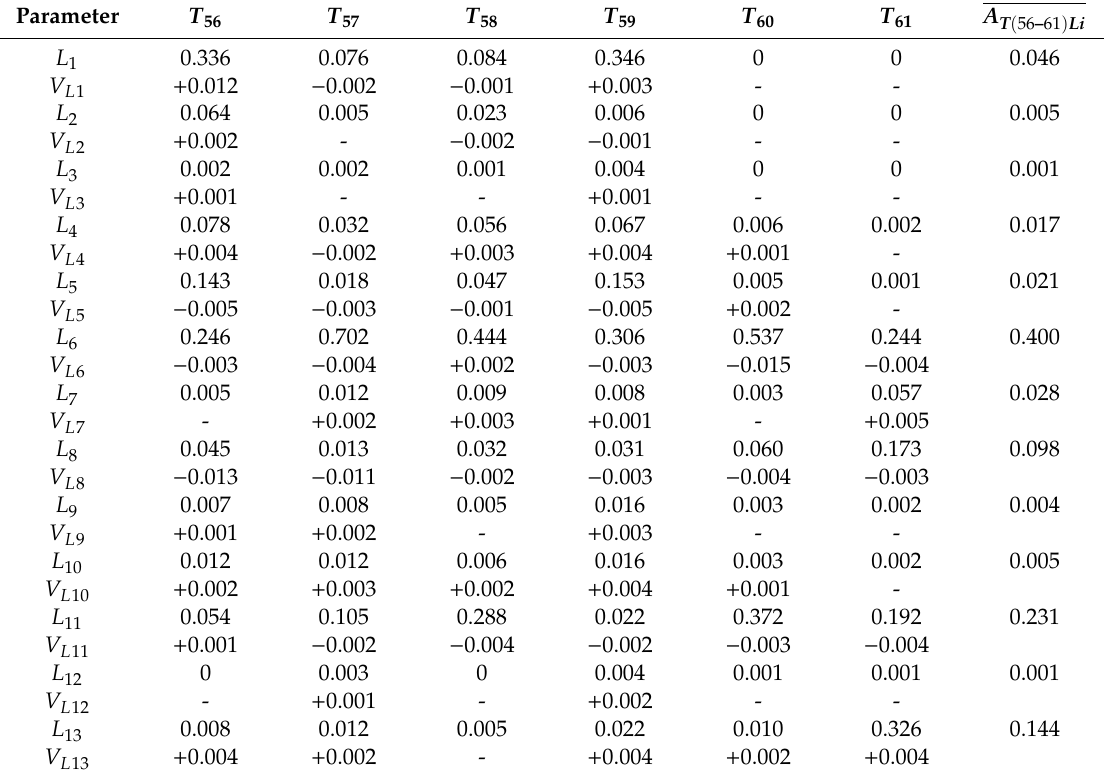
Table A14. Activity per land category in Russia, Ural Federal District. Mean values for 2010–2018.